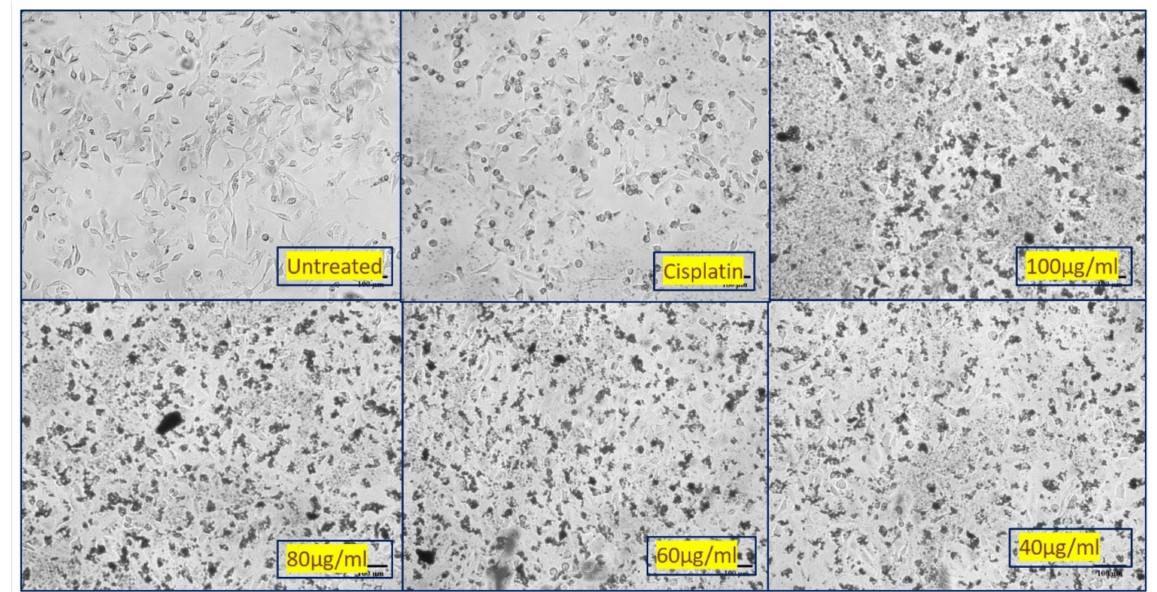
Figure 8. The viability assay of cytotoxicity of NiO NPs against cancer cell line (A549) treated with different concentrations of NiO